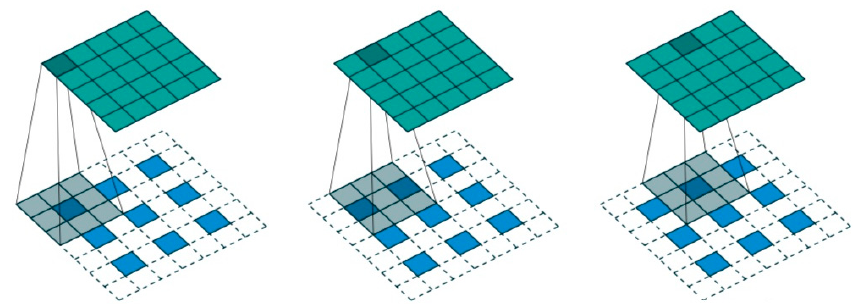
Figure 3. Transposed convolution. Figure 3. transposed convolution. Figure 3. transposed convolution.